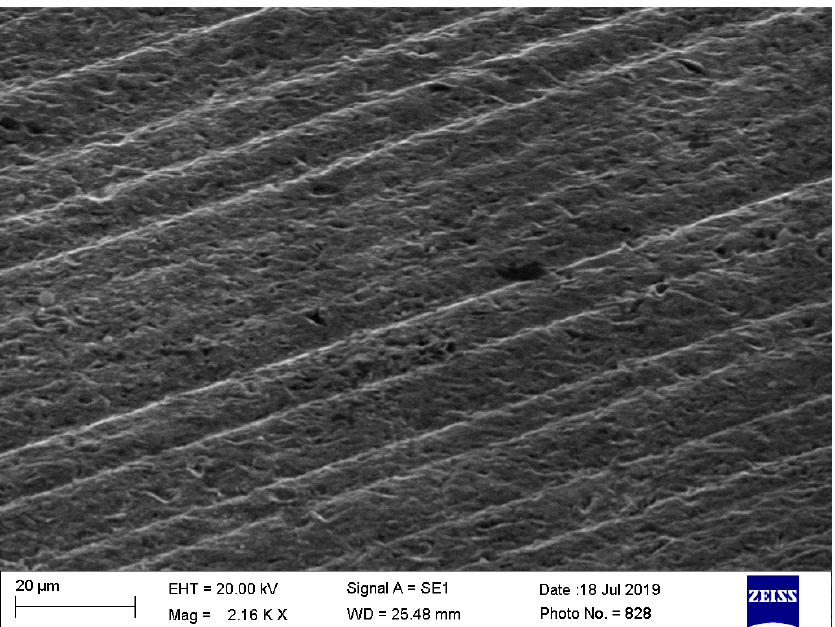
Figure 9. Details of the SEM analysis of the drills used in the present experiment (Mag. 2.16 Kx).